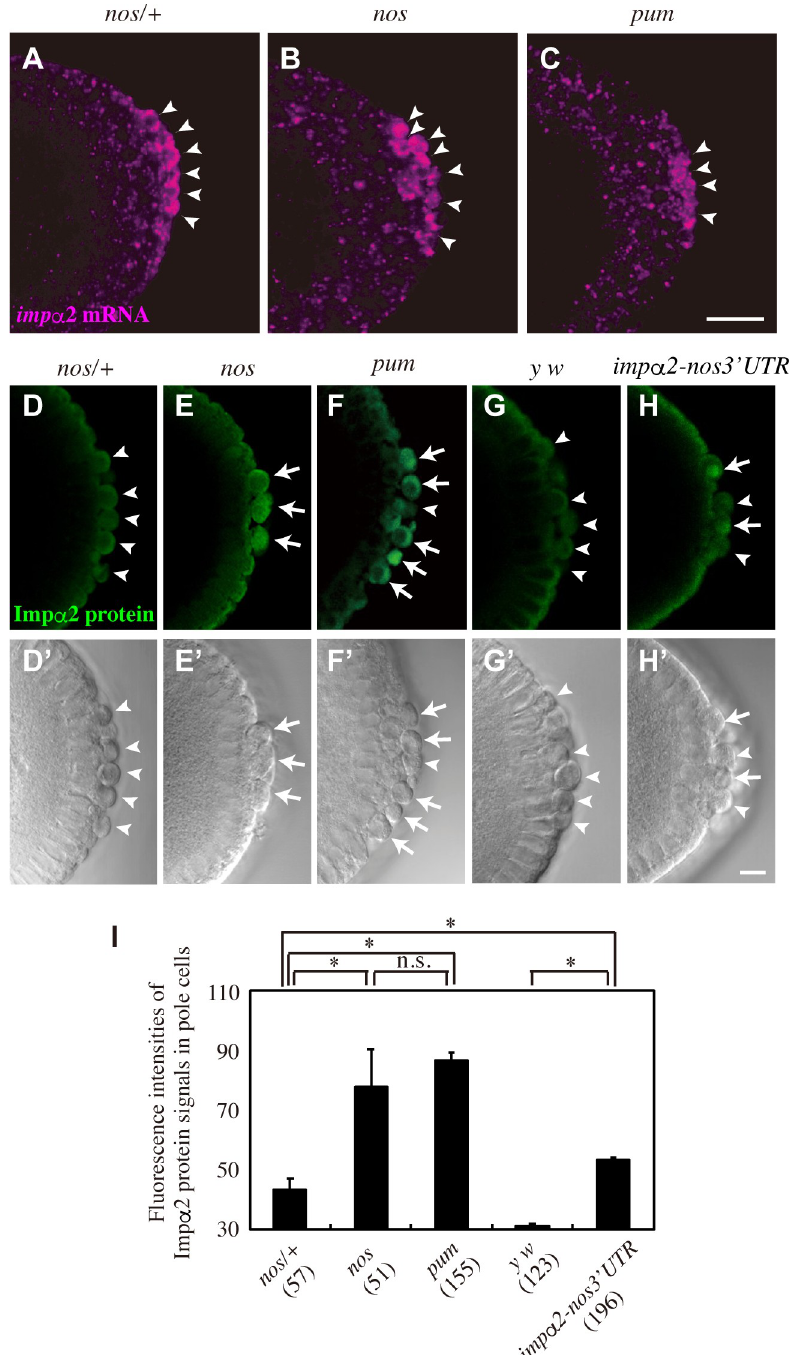
Fig 1. Nos and Pum repress Imp α 2 production in pole cells. ( A–C ) imp α 2 mRNA expression in pole cells of embryos derived from nos /+ ( A ), nos/nos ( nos ) ( B ), and pum/pum ( pum ) females ( C ) mated with y w males. Stage-5 embryos were stained for imp α 2 mRNA. Arrowheads point to pole cells. ( D–H , D’–H’ ) Imp α 2 protein expression in pole cells of embryos derived from nos/ + ( D and D’ ), nos ( E and E’ ), and pum females ( F and F’ ), and y w females with ( imp α 2-nos3´UTR ) ( H and H’ ) or without two copies of imp α 2-nos3´UTR ( y w ) ( G and G’ ). Stage-5 embryos were stained with anti-Imp α 2 23aa antibody (green, D–H ), which recognizes only Imp α 2 protein among the Importin- α family of proteins [48]. DIC images ( D’–H’ ) are also shown. Arrows and arrowheads point to pole cells with and without Imp α 2 expression, respectively. Scale bars, 20 μ m ( C ) and 10 μ m ( H’ ). ( I ) Fluorescence intensities of Imp α 2 protein signals in pole cells of embryos derived from nos /+, nos , pum , y w , and imp α 2-nos3´UTR females.